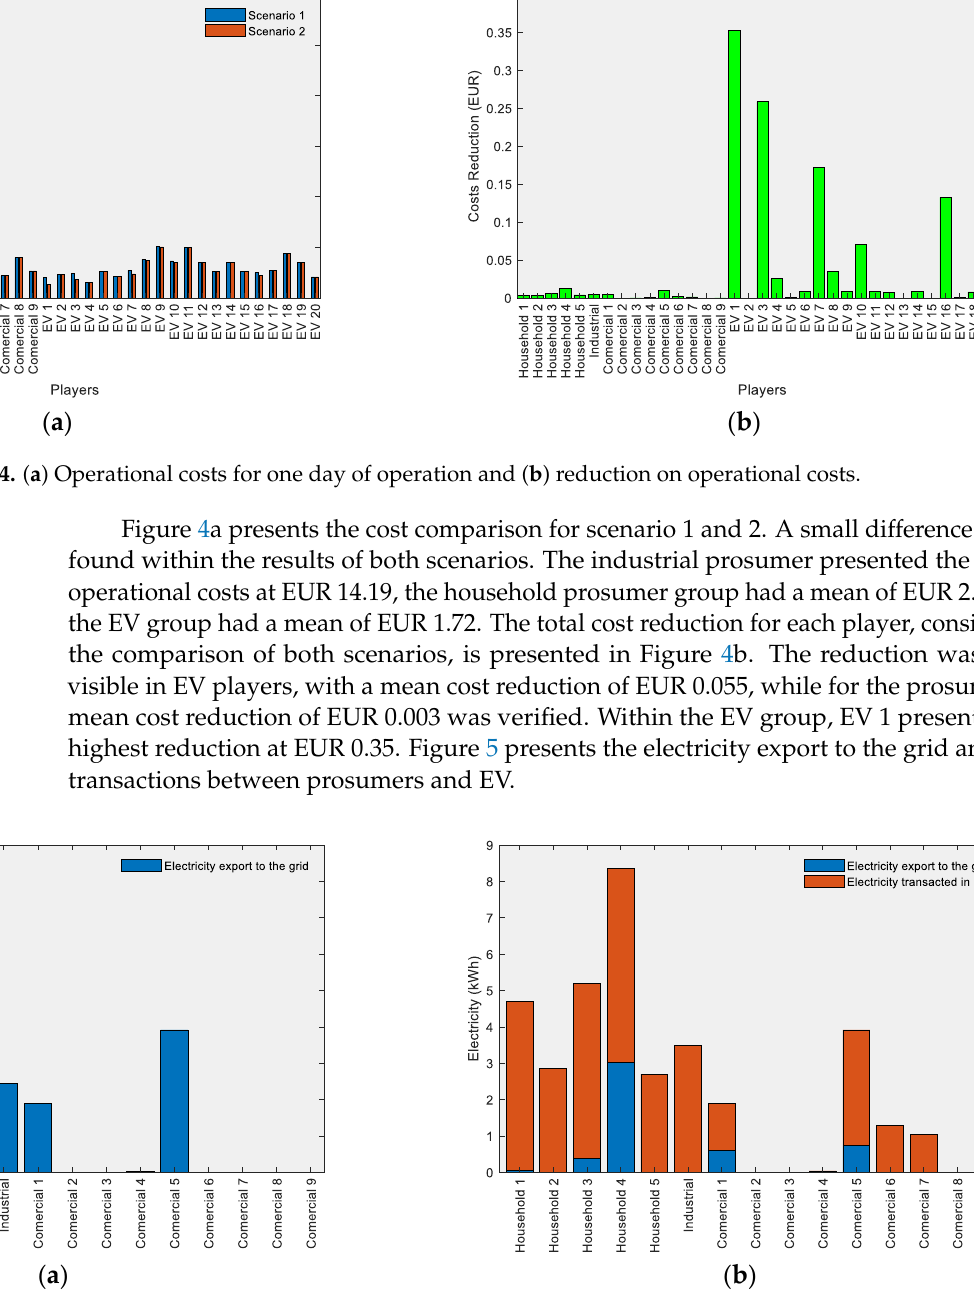
( b ) Figure 6. Electricity acquisition by EVs: ( a ) Scenario 1 and ( b ) Scenario 2. Electricity acquisition by EVs for scenario 1 is presented in Figure 6a and for scenario 2 in Figure 6b. The total electricity bought by EVs was equal in both scenarios at 204.74 kWh. As explained before, some EVs have the possibility to charge the battery directly at